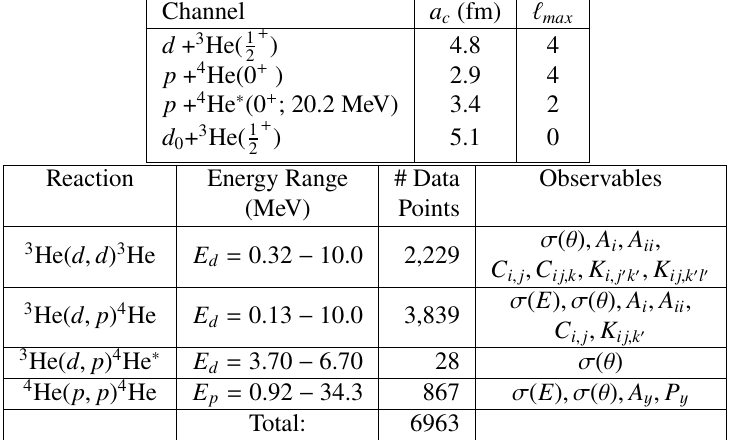
estimate using eq. (9), the scaling of the uncertainty of p α